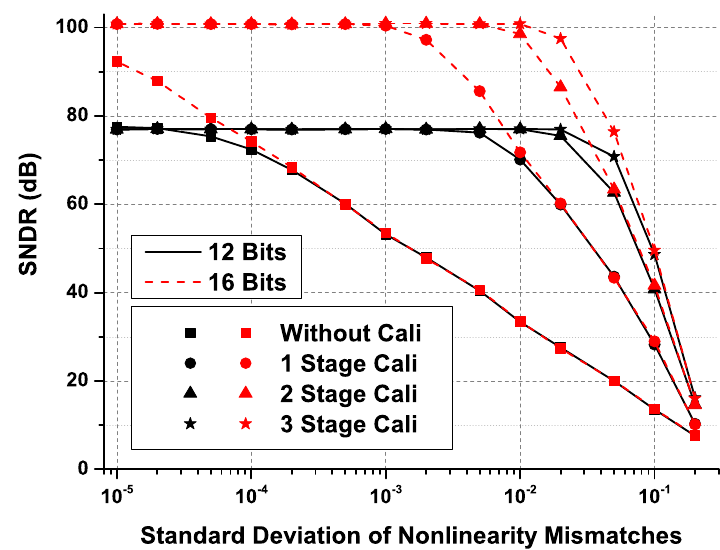
Figure 17. The SNDR of calibrated 4-TIADC output with different strengths of nonlinear